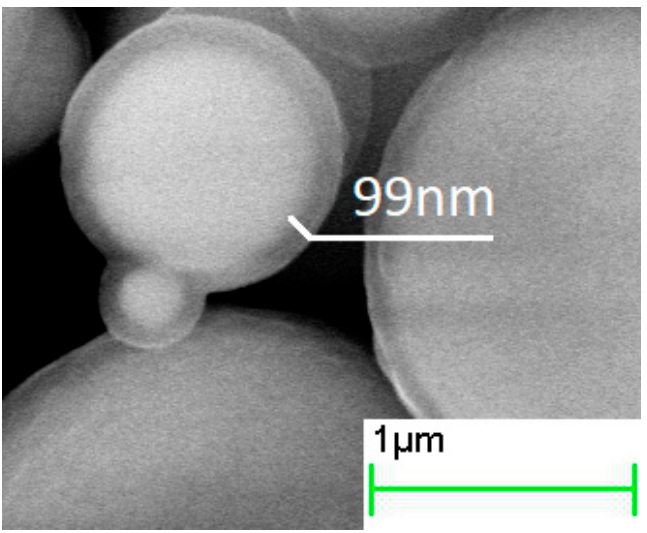
Figure 2. SEM images of core–shell particles obtained in the processes with 0.5 h hydrolysis duration.